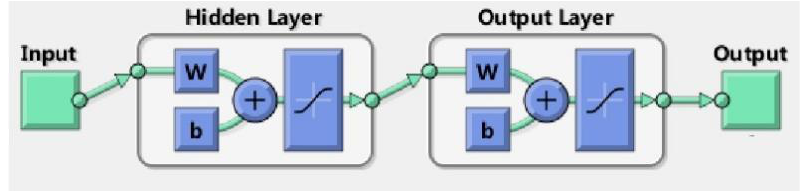
Figure 7. The BP neural network system structure constructed using the MATLAB software neural toolbox.